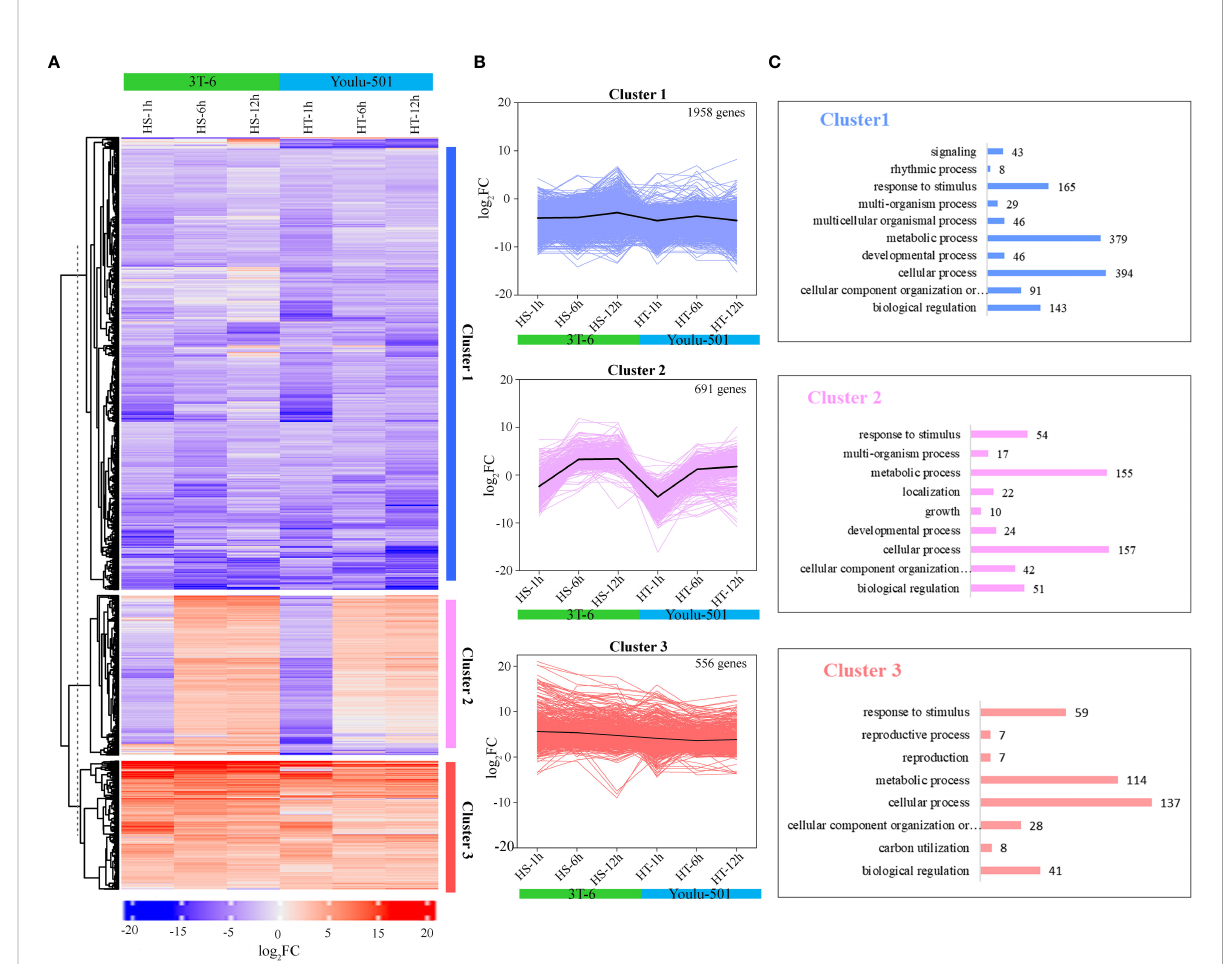
FIGURE 4 Expression patterns of differentially expressed genes (DEGs) and their functional annotation in heat-sensitive (3T-6) and heat-tolerant (Youlu- 501) fl owering Chinese cabbage in response to heat stress. (A) Hierarchical clustering analysis indicates DEG expression patterns in 3T-6 and Youlu-501 after 1, 6, and 12 h of heat stress relative to their controls; (B) Cluster analysis shows that the lines re fl ect expression patterns for each DEG at heat-stress time points. Black lines in each cluster indicate mean changes in DEG expression; (C) Gene ontology enrichment analysis of DEGs in each